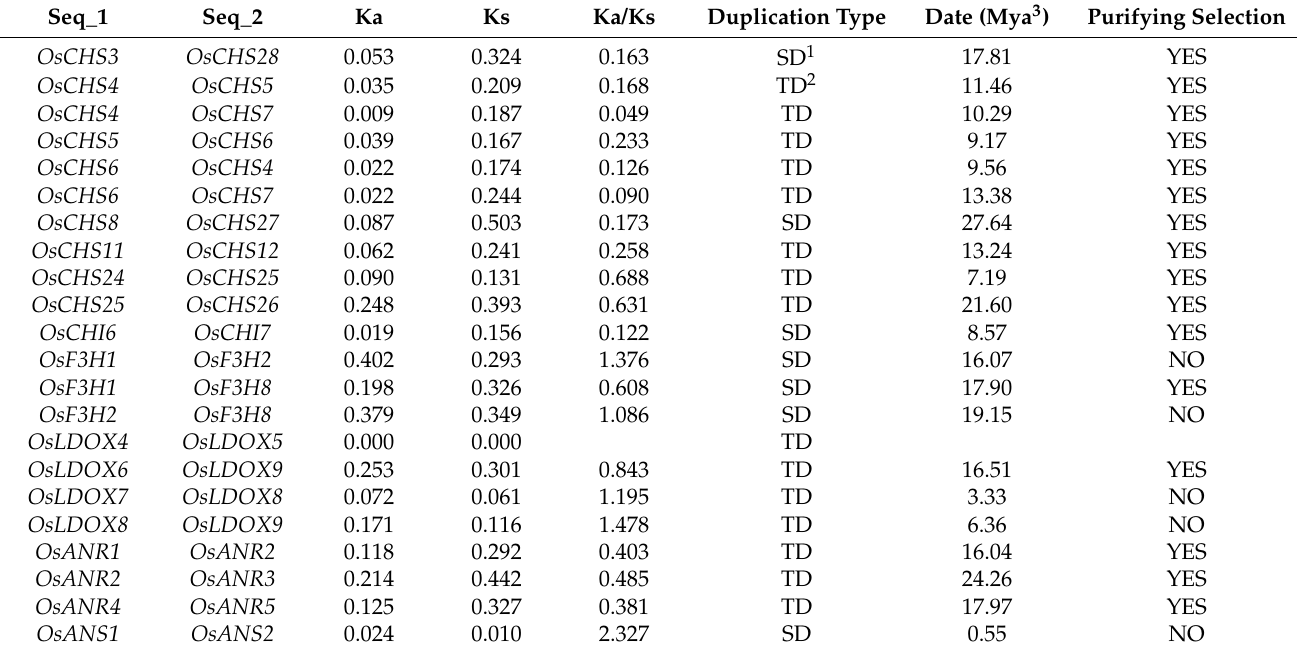
Table 2. Ka/Ks and divergence time analysis for the duplicated paralogs in rice flavonoid